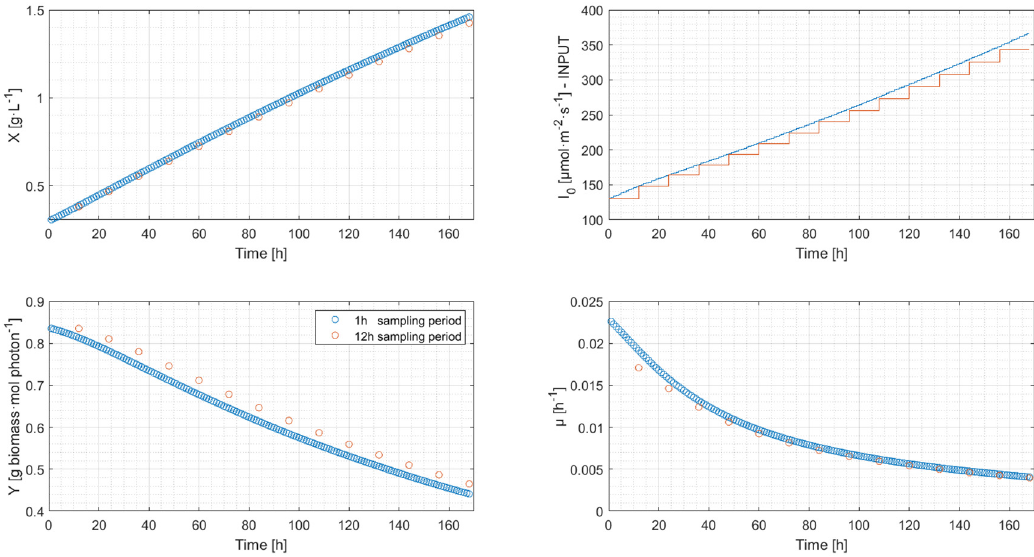
Figure 8. Simulation results on a 7-day batch with different sampling periods (1-h sampling period—blue and 12-h sampling period—red).